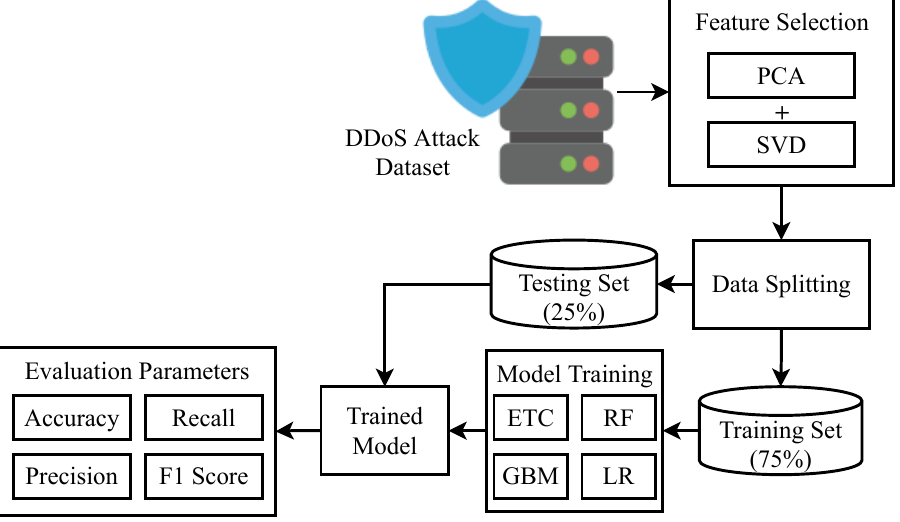
Figure 2. Flow diagram of the proposed